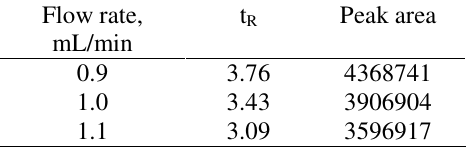
Table 10. The influence of small changes in flow rate (Method